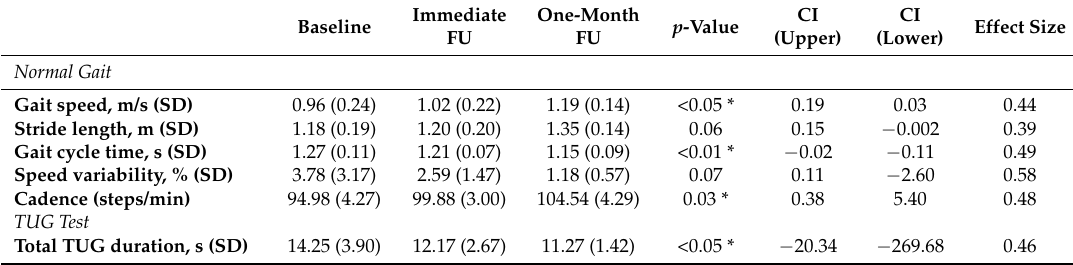
Table 3. Results from repeated measure ANOVA for gait and TUG parameters. Mean (SD: standard deviation), p -values, confidence intervals (CIs), and effect sizes are presented. An asterisk indicates statistical